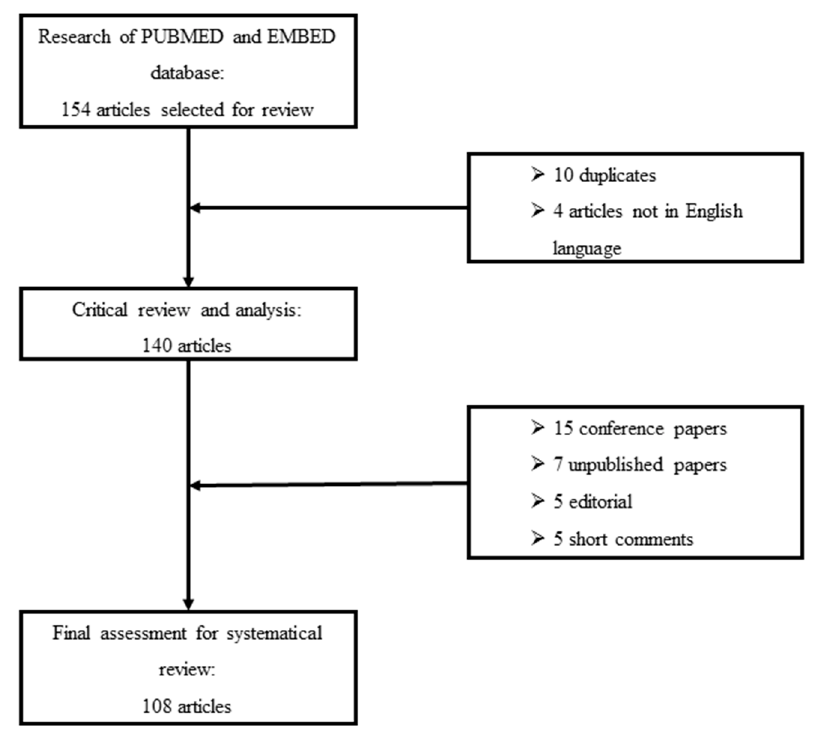
Figure 1. Flowchart of critical review and selection for inclusion of papers in the systematic review.